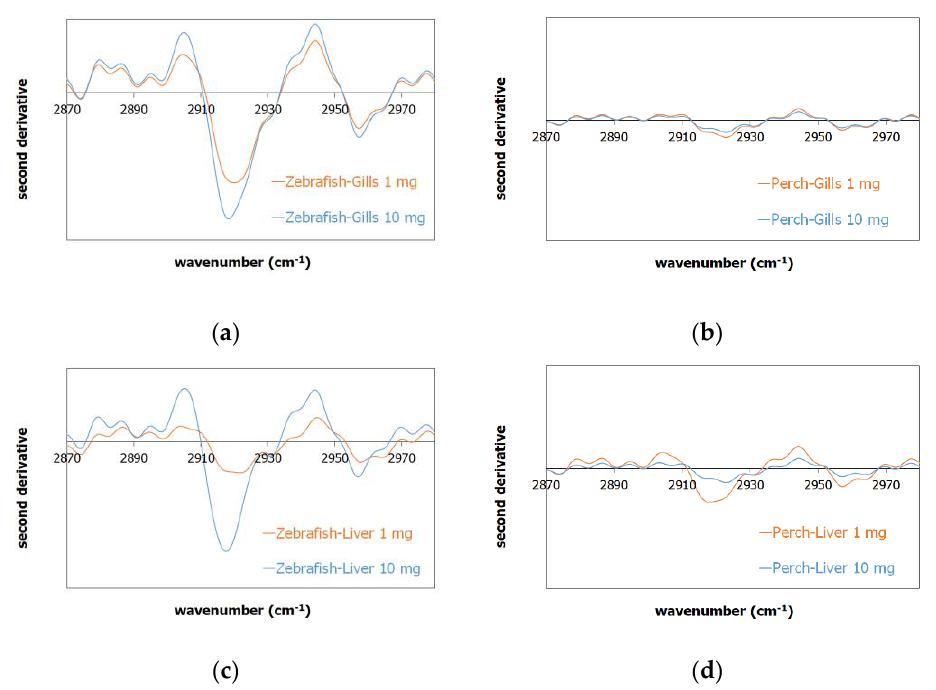
Figure 1. Second derivative of the FTIR spectrum of the exposed sample to 1 mg of PP (orange line) and 10 mg of PP (blue line) in the ( a ) zebrafish gills, ( b ) perch gills, ( c ) zebrafish liver, and ( d ) perch liver, where the downside peaks at 2920 and 2950 cm −1 are related to the presence of PP.